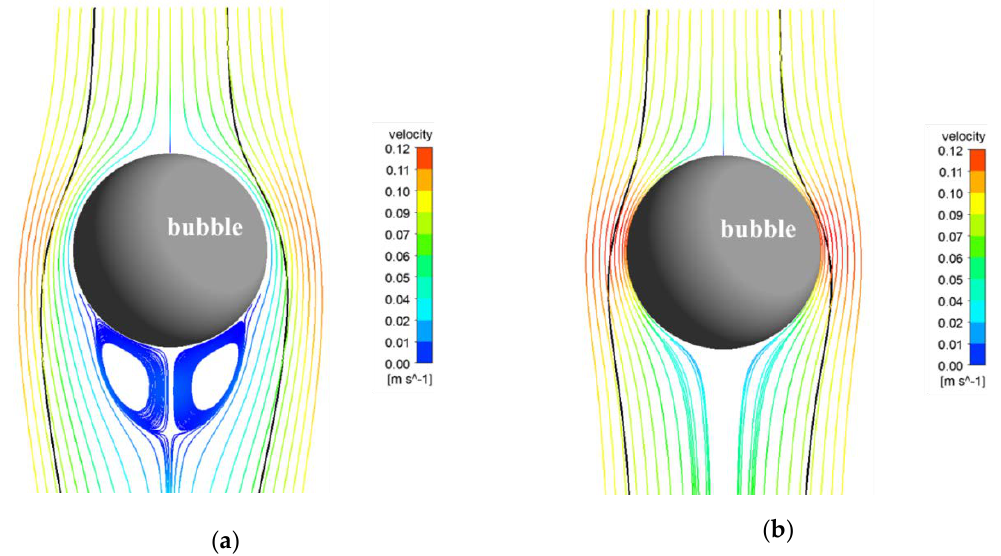
Figure 7. Particle tracks and mean streamlines for bubble diameter of 0.9 mm and galena particle